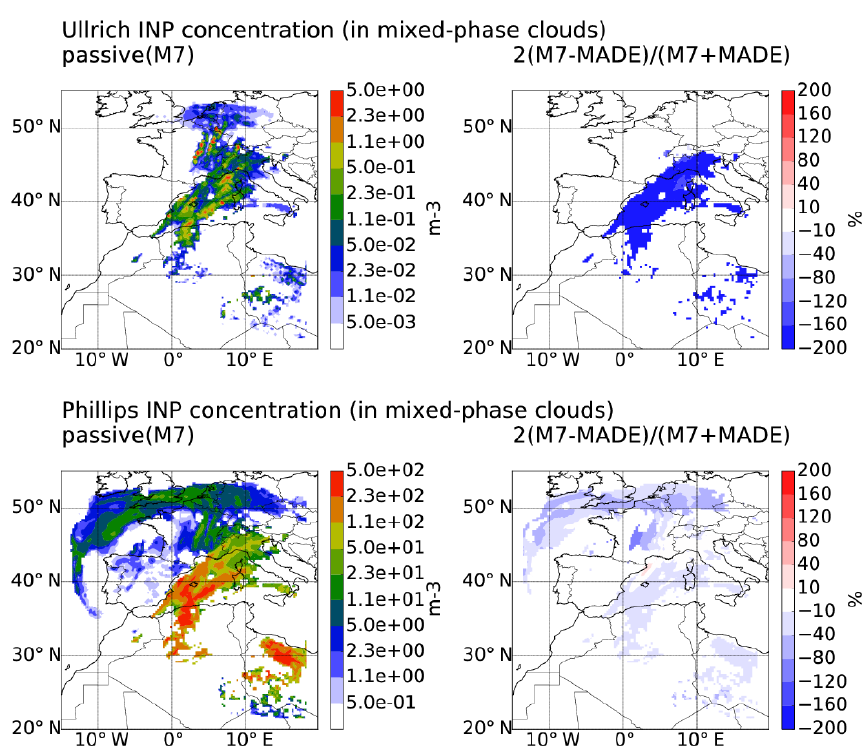
Figure 12. Mixed-phase INP concentrations derived from aerosol compositions predicted by M7 (left column) and MADE (relative- difference plots in the right column) using the Ullrich (first row) and Phillips (second row) parameterizations for Passive simulations. See Fig. 3 for plot details. Contours show vertical averages of concentrations in grid boxes that contain both ice- and liquid-phase cloud